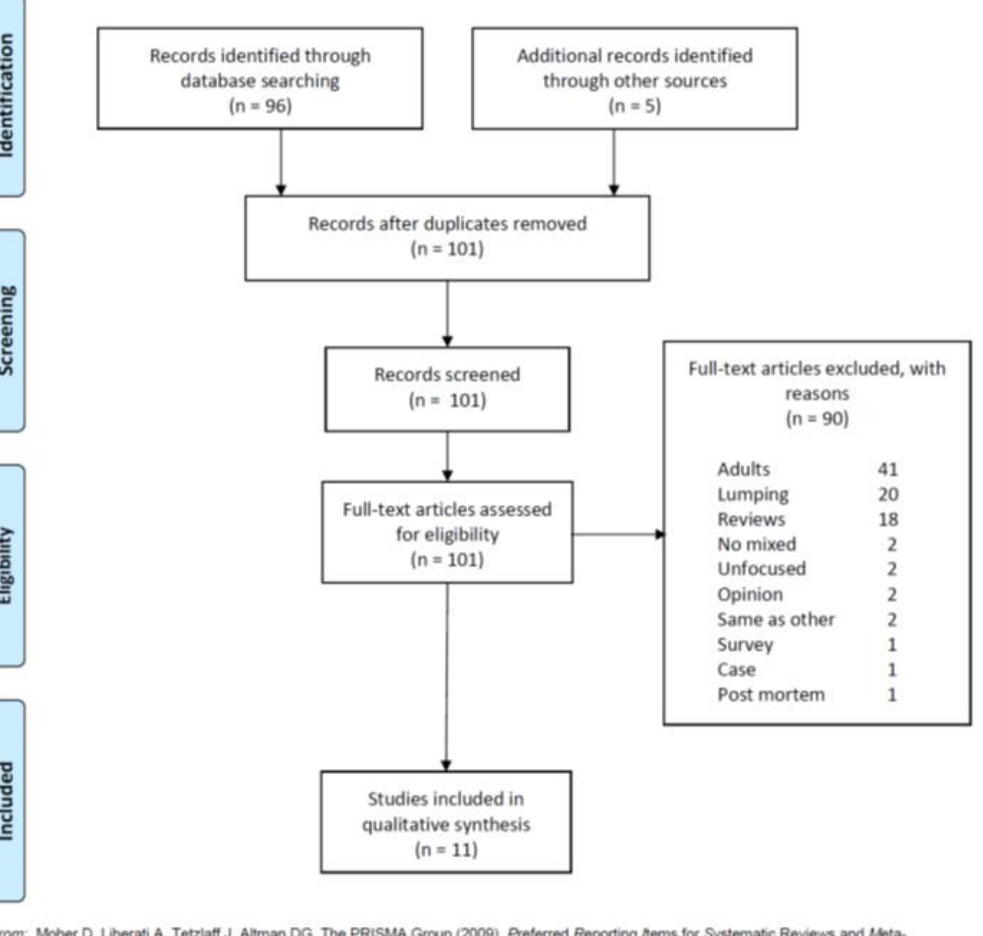
Figure 1. Preferred Reporting Items for Systematic Reviews and Meta-Analyses (PRISMA) flow diagram of the inclusion strategy with exclusion reasons (after Moher et al., 2009 [18]).